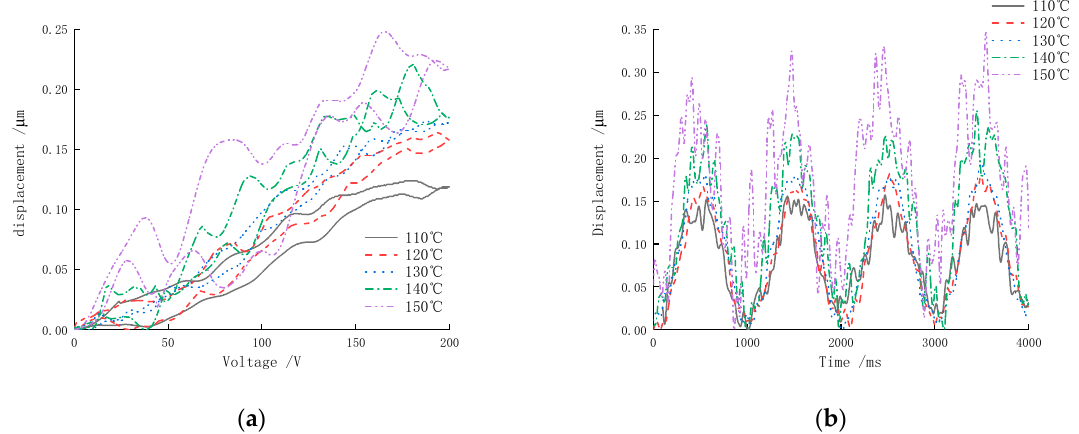
Figure 14. Displacement versus the polarization voltage: ( a ) response curves; ( b ) time-domain curves (four cycles).